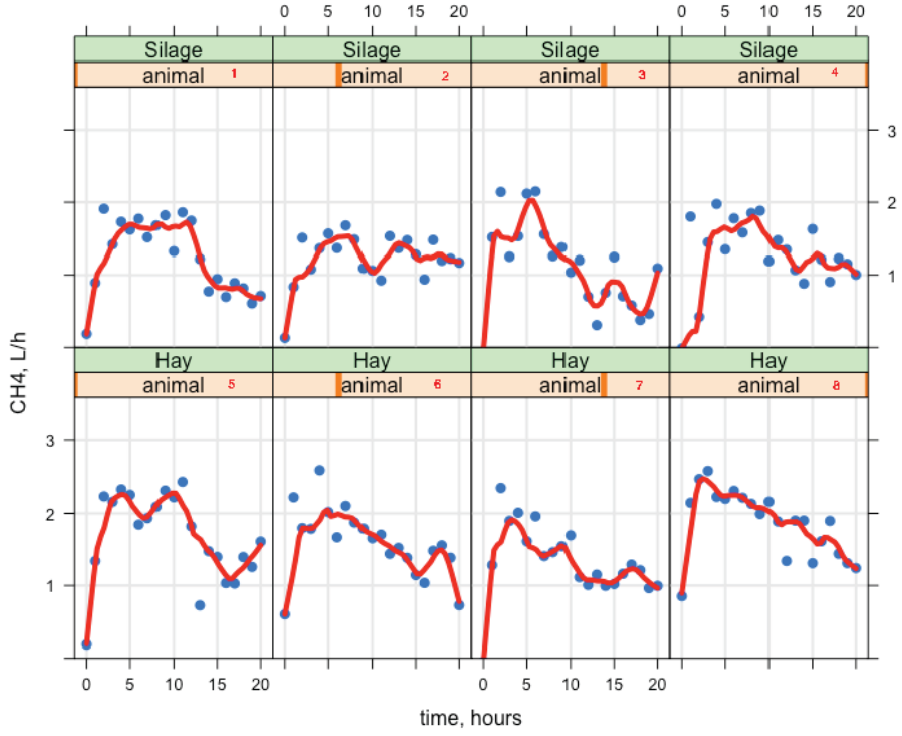
Figure 4. Methane (CH 4 ) production in 8 lactating dairy goats consuming diets composed of 40% forage (either alfalfa hay [Hay] or alfalfa silage [Silage]) and 60% of concentrate; observation data (points) and smooth regression (solid line).